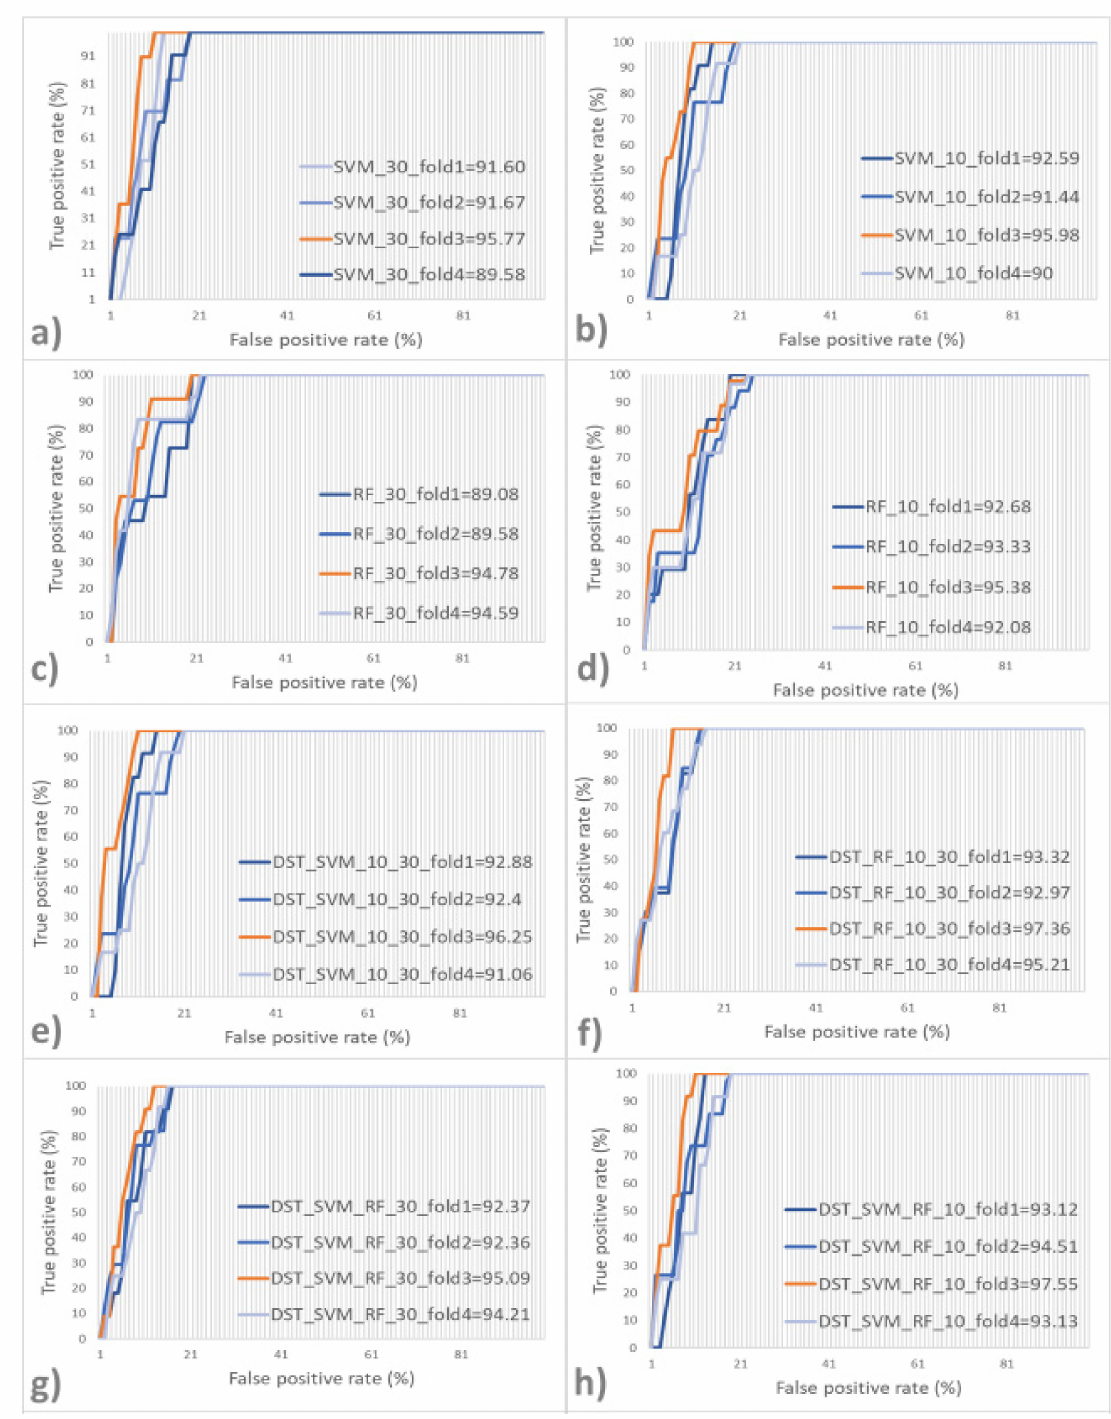
Figure 12. The resulting ROC curves based on the four-fold CV for ( a ) SVM by coarse dataset 30 m, ( b ) SVM by medium dataset 10 m, ( c ) RF by coarse dataset 30 m, ( d ) RF by medium dataset 10 m, ( e ) DST using SVM results for coarse 30 m and medium 10 m datasets, ( f ) DST using RF results for coarse 30 m and medium 10 m datasets, ( g ) DST using results from SVM and RF-based on coarse dataset 30 m, ( h ) DST using results from SVM and RF-based on medium dataset 10 m. The corresponding ROC curve of the highest value of AUC measurement in each four-fold is specified by orange